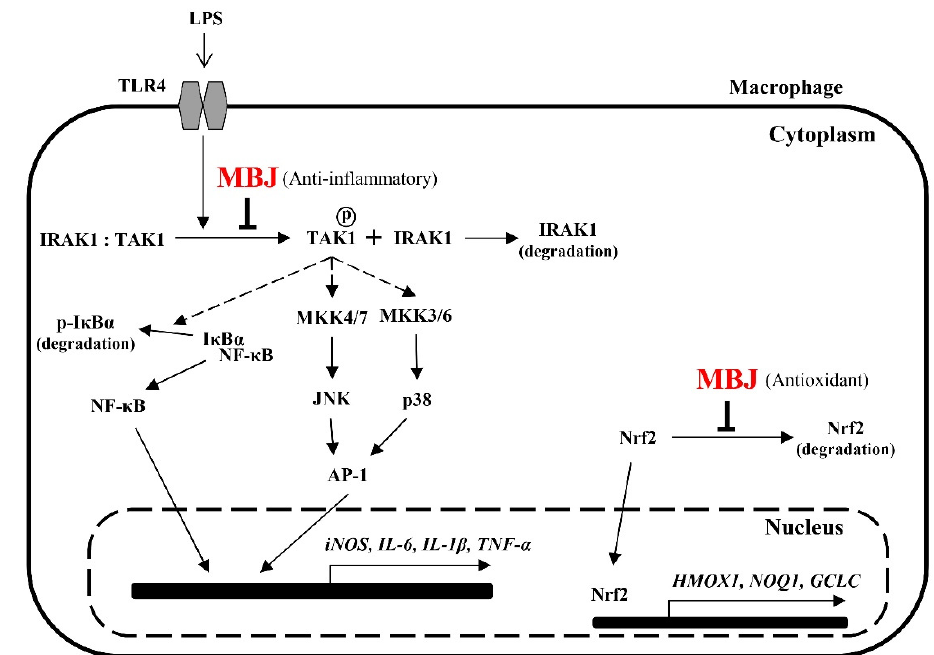
Figure 7. Molecular pathways that mediate the antioxidant and anti-inflammatory effects of MBJ in RAW 264.7 cells. MBJ may affect inflammatory mediators by regulating signal transduction from TLR4 to IRAK1 and inhibiting the activation of the NK- κ B and MAPK signaling pathways. Further, MBJ may affect oxidative stress regulation by inducing the translocation of Nrf2 to the nucleus, thereby inducing downstream gene expression.